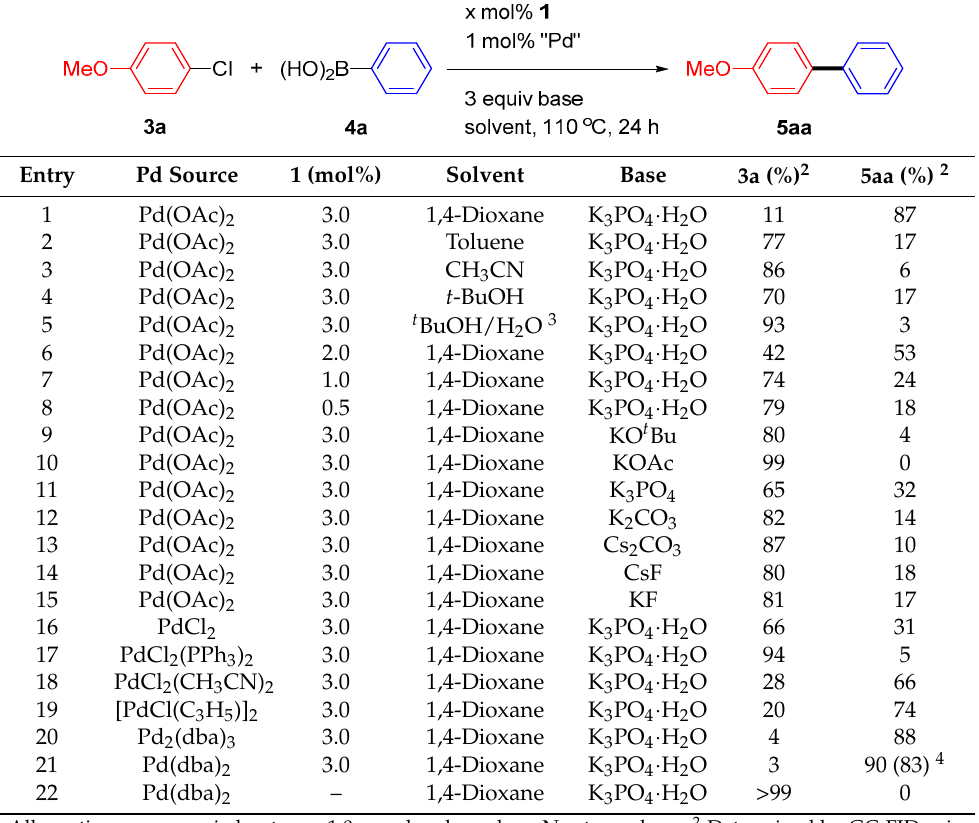
Table 1. Screening the optimized reaction conditions of in situ-formed catalyst 1 .